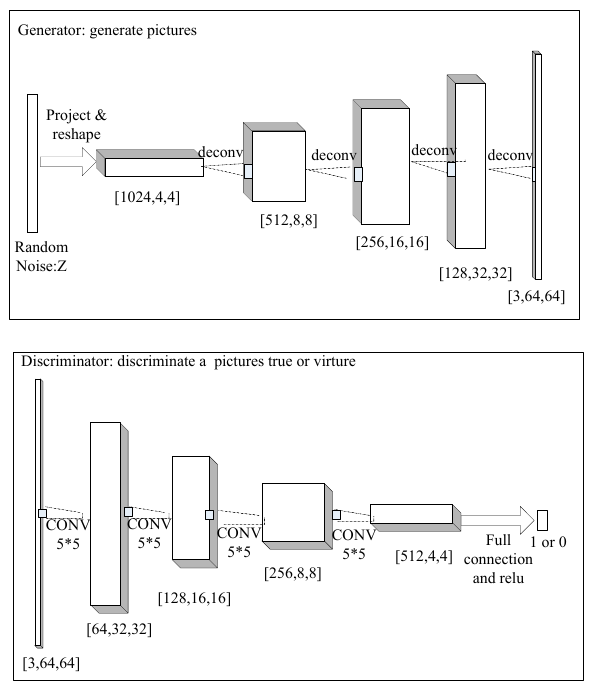
Figure 3. The framework of the generator and discriminator model in Generate Adversarial Network.